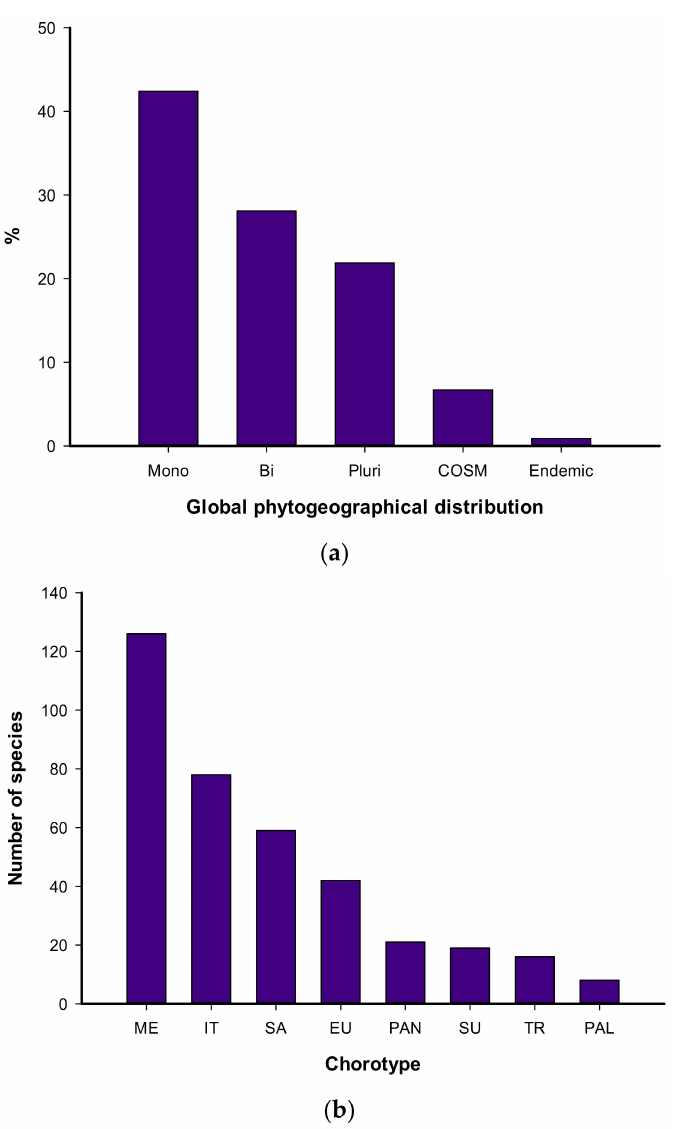
Figure 4. The global phytogeographical distribution of the species ( a ), chorotype spectrum of the recorded species in the study area ( b ). COSM: Cosmopolitan, Pluri: Pluri-regionals, SA: